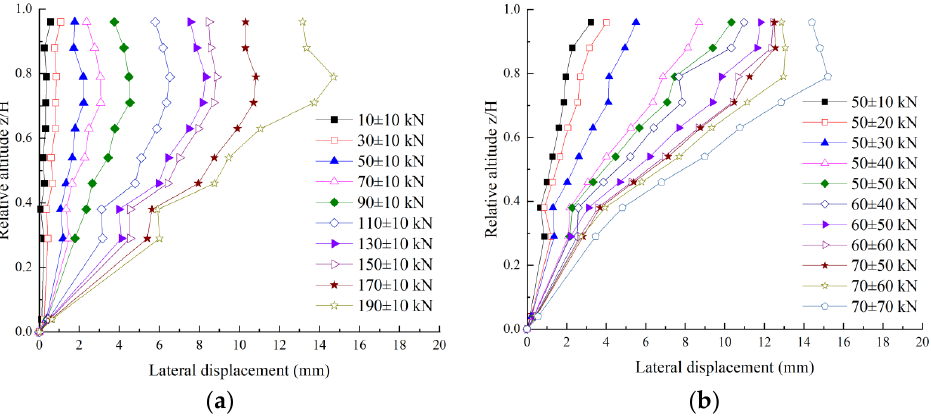
Figure 7. Lateral deformation of wall facing. ( a ) Equal amplitude loading. ( b ) Equal frequency loading.